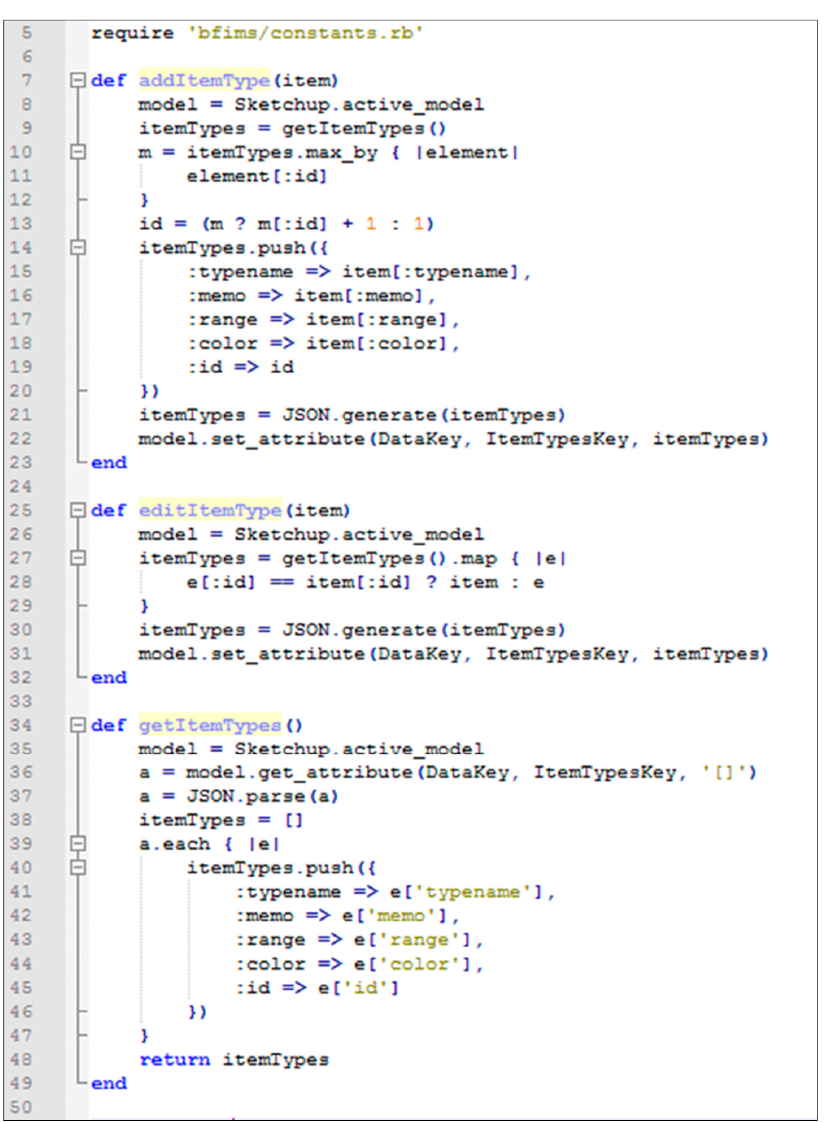
Figure 5. System code: data input.